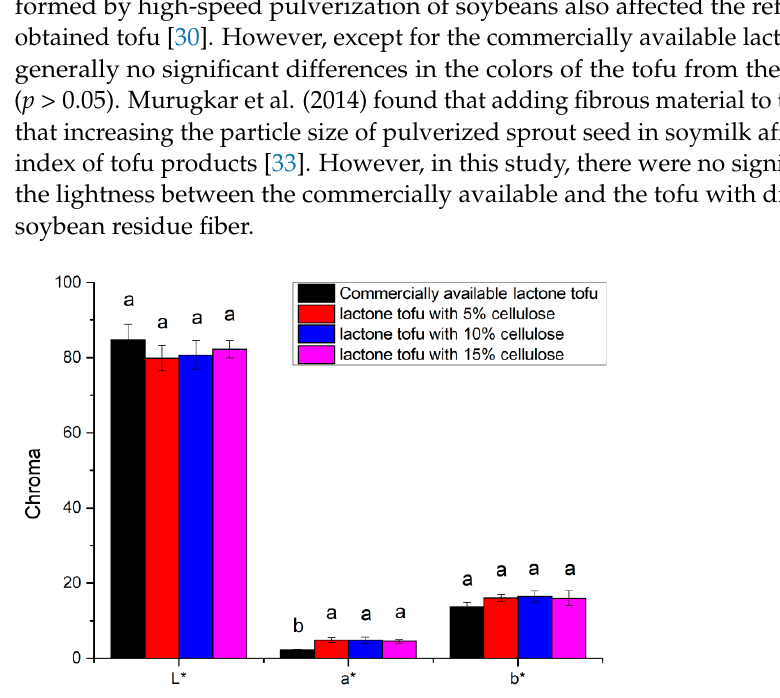
Figure 5. Chroma analysis of the different tofu types.